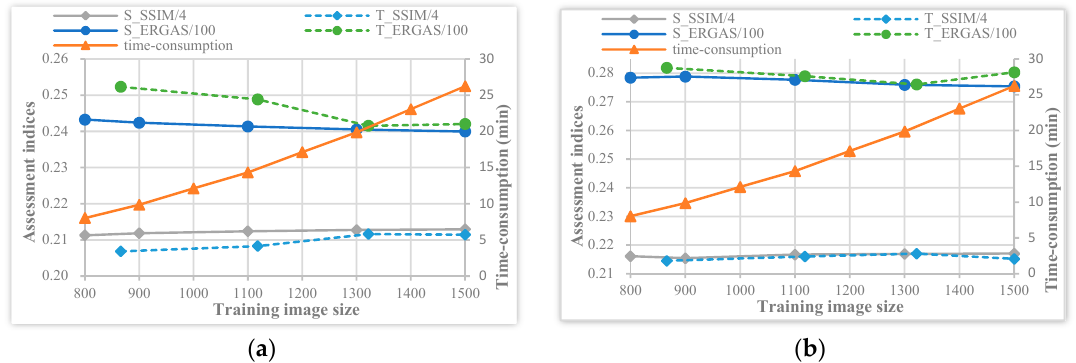
Figure 11. Proposed bi-directional fusion strategy in the temporal extension of training samples using the urban dataset, ( a ) and ( b ) are respectively for modeling the reflectance on 10 July and 12 September 2017.